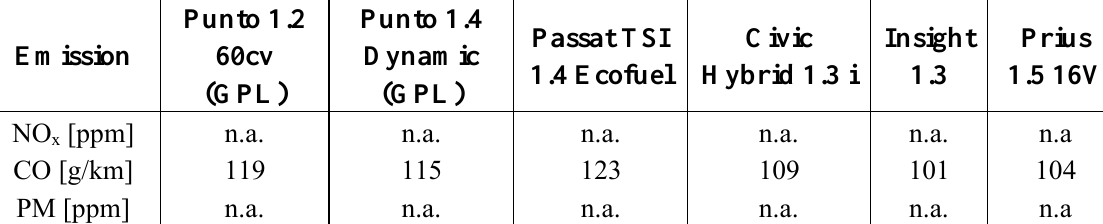
Table 22. CO emissions of commercial passenger sedan